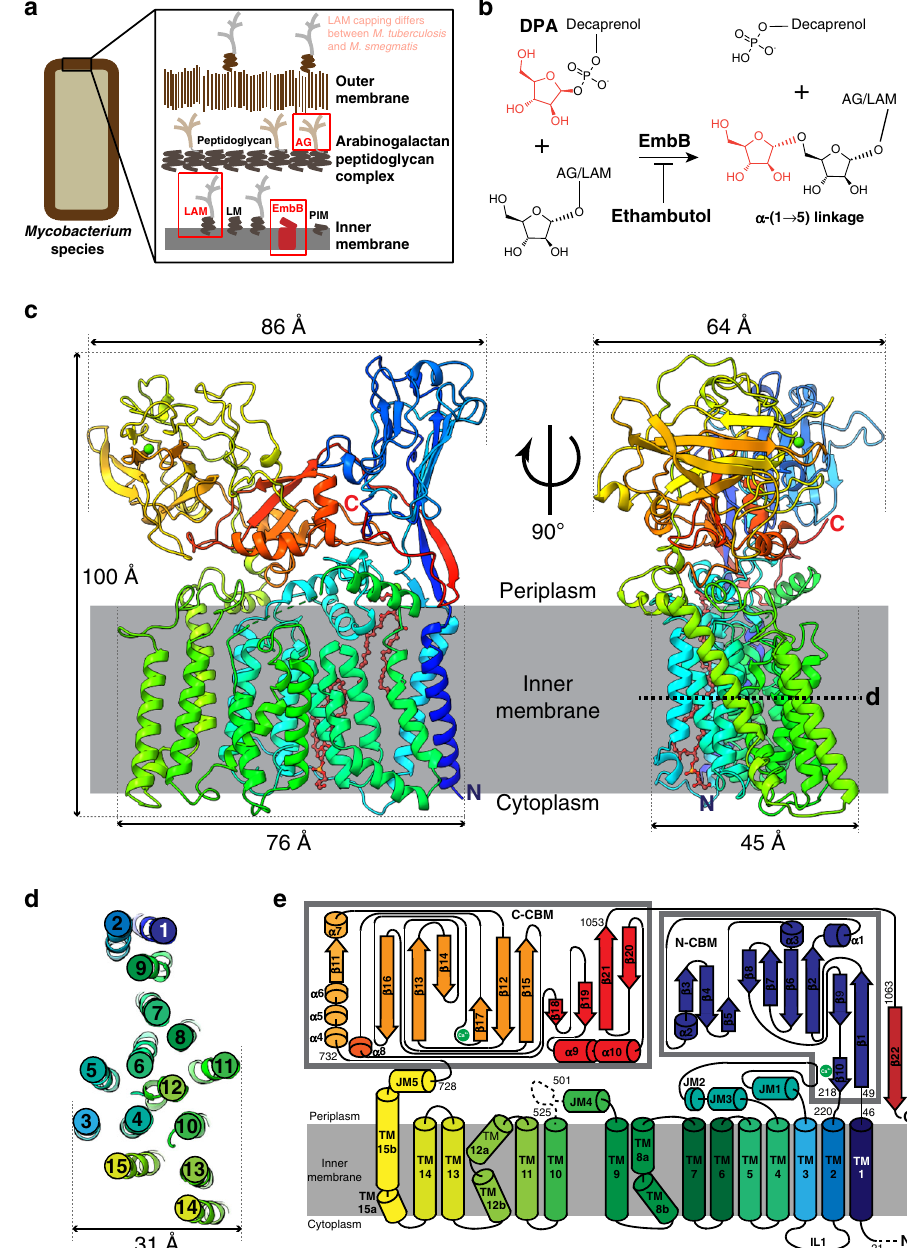
Fig. 1 Cryo-EM structure of EmbB. a Model of the cell envelope of mycobacterial cell envelope based on Dulberger et al. 75 . Red boxes highlight arabinogalactan (AG) and lipoarabinomannan (LAM) components, synthesized by EmbA/EmbB (red) and EmbC, respectively. LAM for M. tuberculosis is capped by α -mannose glycans while in M. smegmatis it is capped by phosphoinositol instead 76 . b Reaction catalyzed by EmbB, which is inhibited by ethambutol. c Single-particle cryo-EM structure of EmbB, rendered in cartoon form and colored in rainbow from N terminus (blue) to C terminus (red). A Ca 2 + ion is shown as a green sphere. The bound lipids are represented as ball-and-sticks, colored in brown. Two orthogonal views that are perpendicular to the plane of the membrane are shown. Membrane boundaries were derived from the interface between the nanodisc lipids and solvent. d Arrangement of the TM helices of EmbB, viewed as a slice in the plane of the membrane, as indicated in ( b ) and magni fi ed. e Two-dimensional topological diagram of EmbB. The two CBMs are enclosed in separate gray boxes. The topology diagram is rainbow colored from N terminus (blue) to C terminus (red). Unbuilt parts of the model, due to poor map density, are indicated by dotted lines. Bound Ca 2 + atoms are shown as green